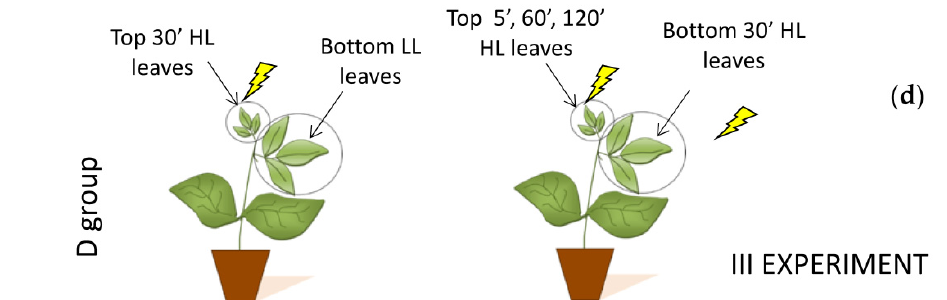
Figure 6. Scheme of the three experiments: First experiment ( a ) In the A plant group, Top HL “inducing” leaves were exposed for 120’ to 2000 PPFD, while the Bottom LL “receiving” leaves were kept for the same duration of time at growth irradiance of 90 PPFD. ( b ) In the B plant group, Top HL “inducing” leaves were exposed for 120’ to 2000 PPFD, while the Bottom HL “receiving” leaves were exposed for 120’ to 2000 PPFD. Second experiment ( c ): In C plant group Top HL leaves were exposed for 5’, 15’, 30’, 60’, and 120’ to 2000 PPFD, while the Bottom LL leaves were kept for the same duration of time at growth irradiance of 90 PPFD. Third experiment ( d ): Finally in the D plant group, Top HL leaves were exposed for 30’ at 2000 PPFD, while the Bottom LL leaves remained unstressed. After Top HL leaves were exposed for 5’, 60’, and 120’ to 2000 PPFD, while the Bottom HL leaves were exposed for 30’ to 2000 PPFD.